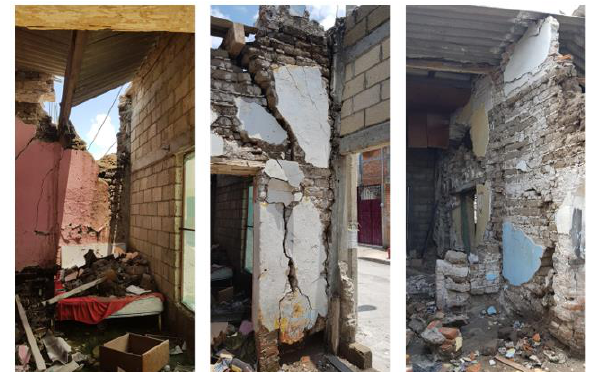
Figure 6. Damages in adobe buildings of Jojutla de Juárez. Photo: Adrià Sánchez Calvillo